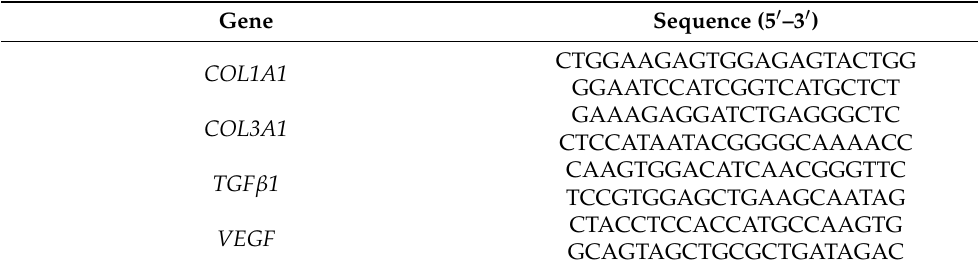
Table 1. Showing the primer sequences of the genes used for real time